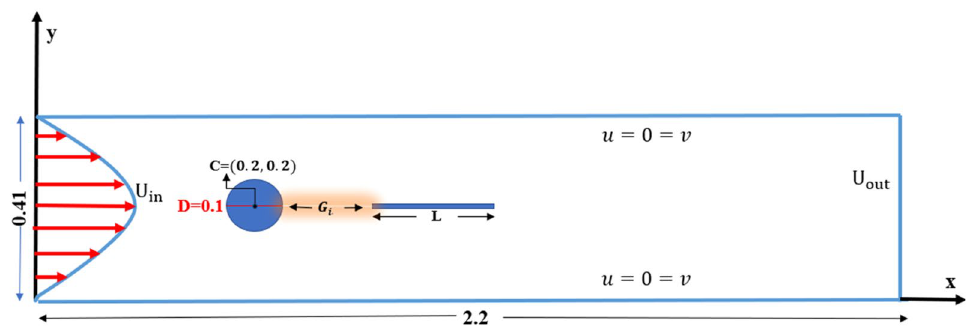
˜ L is fitted at various gap separation